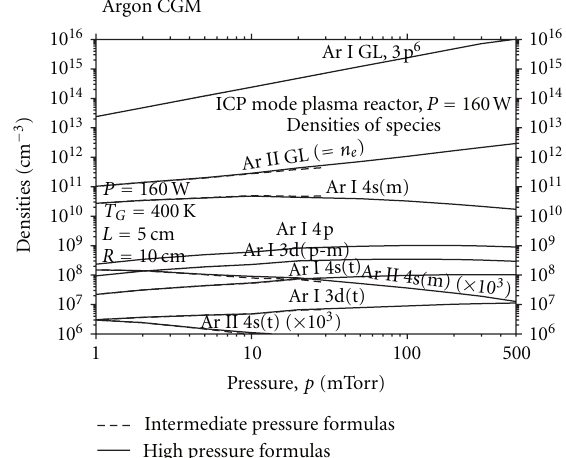
Figure 6: As in Figure 4 but for pressures up to 500mTorr.